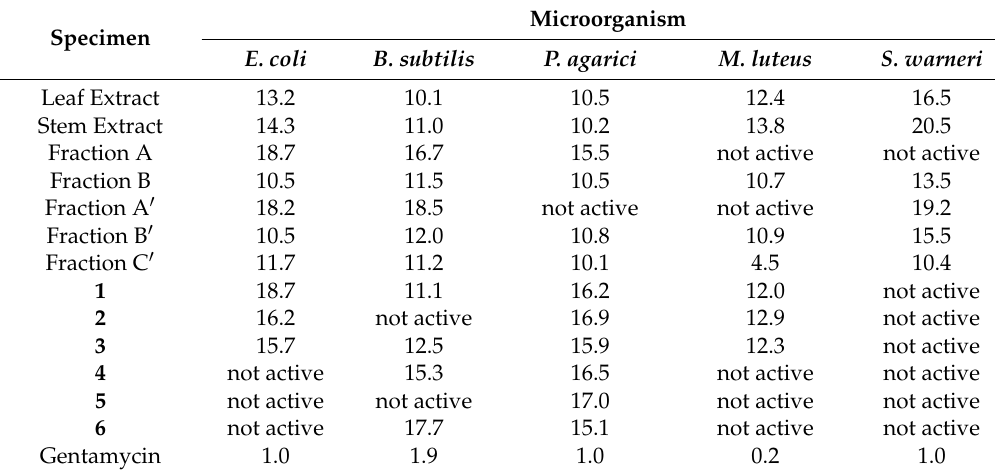
Table 2. Minimum inhibition concentration (MIC, µ g/mL) of leaf and stem extracts, fractions and compounds ( 1 – 6 ) from Vepris lecomteana